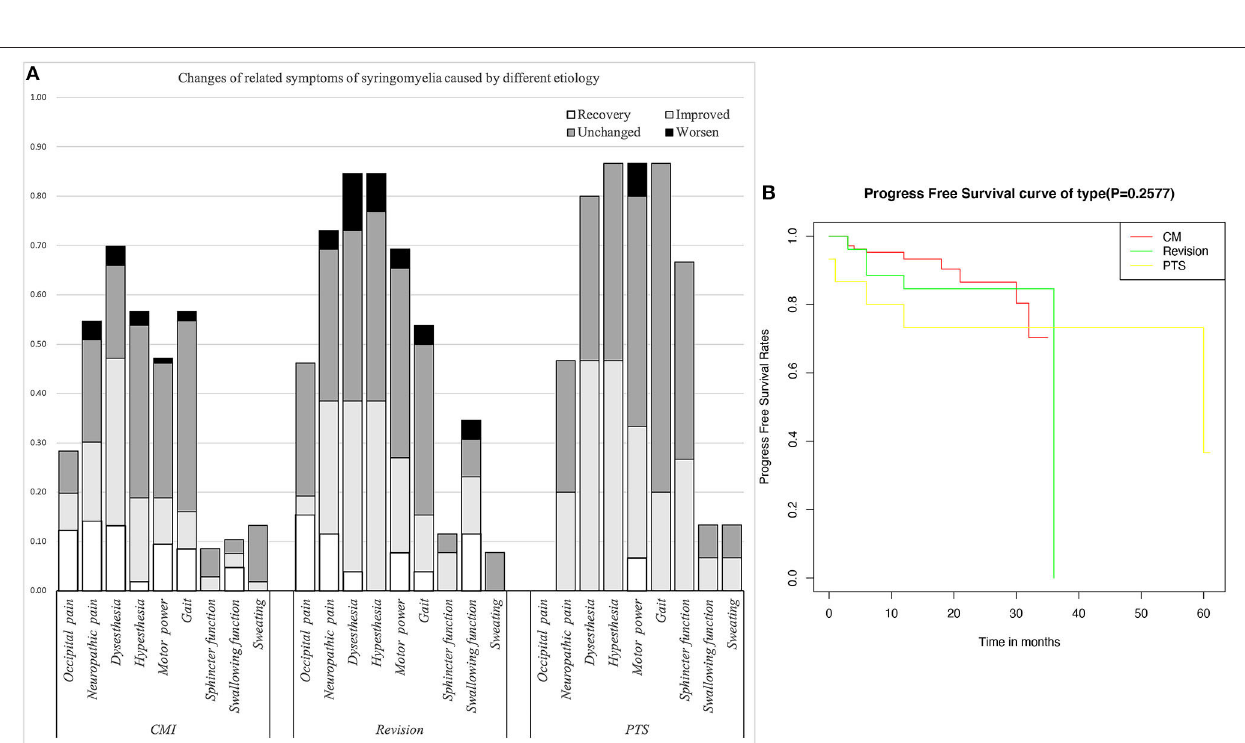
FIGURE 2 | (A) Changes in related symptoms of syringomyelia of different etiologies. (B) Survival curve of syringomyelia.